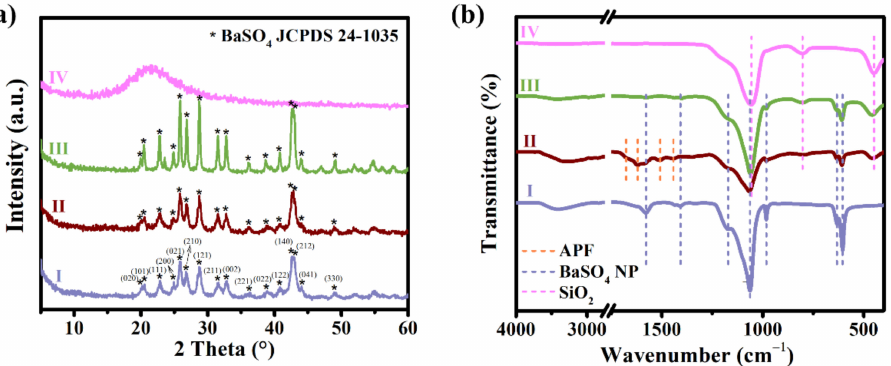
Figure 2. X-ray diffraction (XRD) patterns ( a ) and Fourier transform infrared spectroscopy (FTIR) spectra ( b ) of (I) BaSO 4 NP, (II) BaSO 4 @APF-SiO 2 , (III) BaSO 4 @mSiO 2 , and (IV) HMSN,